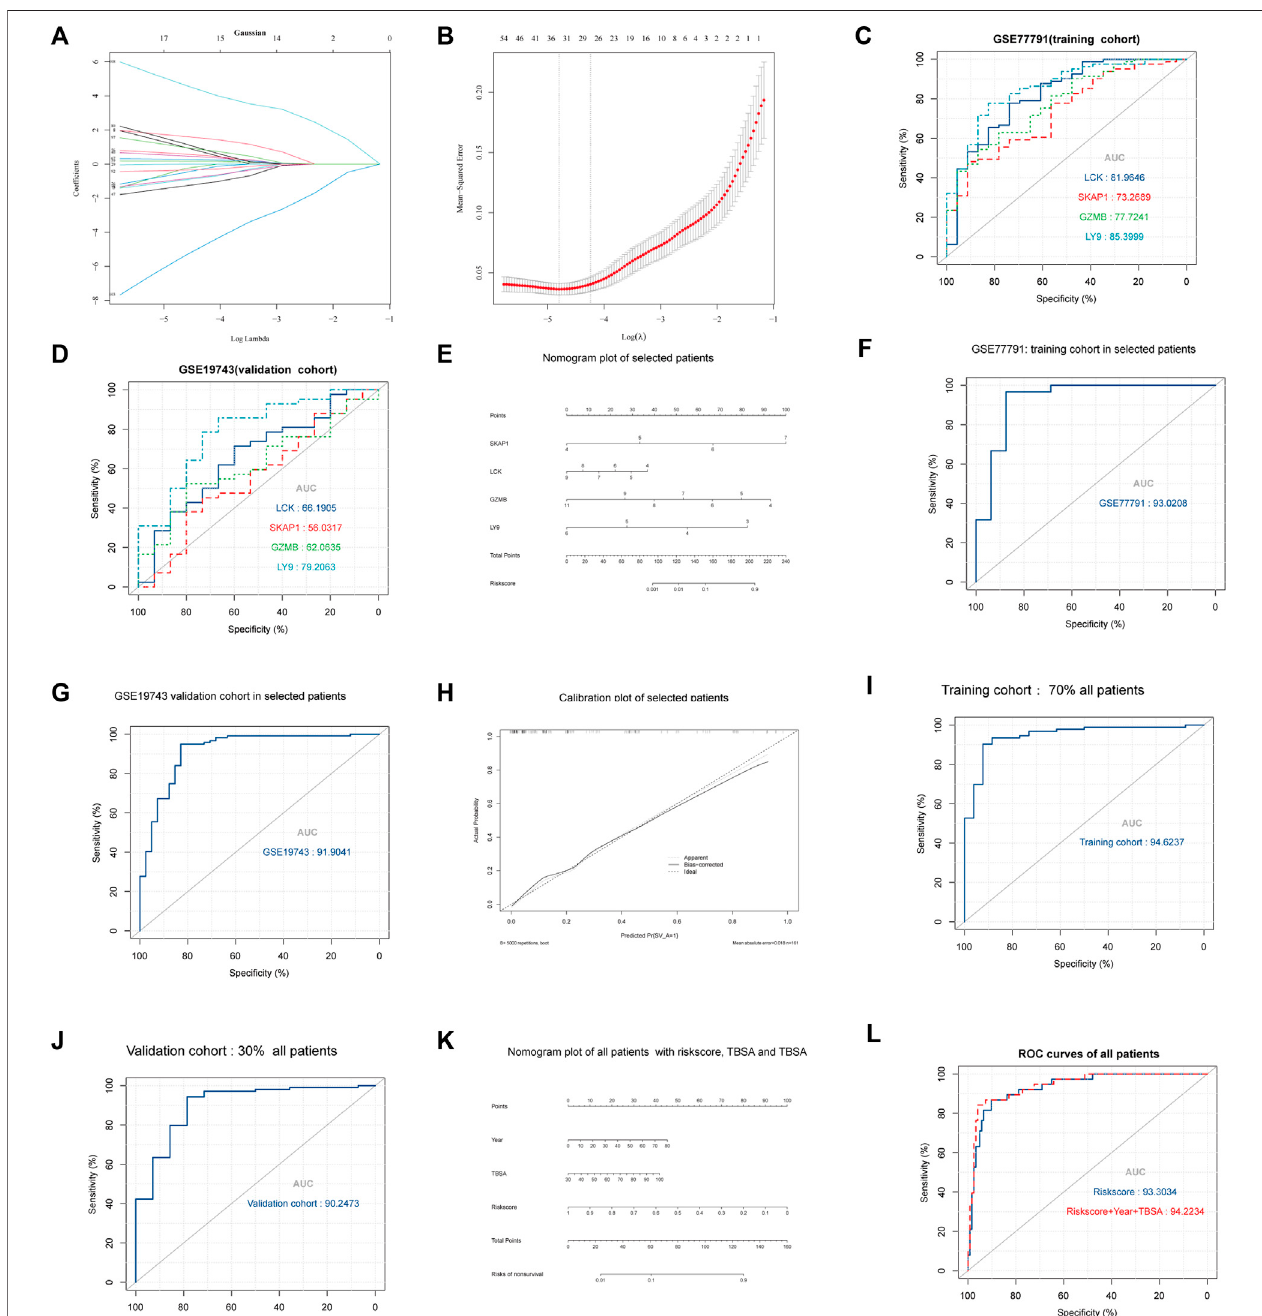
FIGURE 7 | Results of regression, multidimensional veri fi cation, and correlation between key genes and immune cells. (A,B) The ordinate is the correlation coef fi cient between gene expression and prognosis. λ was utilized to screened genes and the number aforementioned is the number of genes. (C) AUC of the four key genes in GSE77791. The larger the area under the curve, the stronger the prediction ability. (D) AUC of the four key genes in GSE19743. (E) Nomogram plot of logistic regression which can be utilized to calculate the risk score between severe burns and controls. (F) AUC of logistic regression with selected patients (18 < age < 55, TBSA > 30, 280 h < sample times < 706) in the training cohort (GSE77791). (G) AUC of logistic regression with selected patients (18 < age < 55, TBSA > 30%, 280 h < sample times < 706) in the validation cohort (GSE19743). (H) Calibration curve of logistic regression. The closer bias-corrected curve and ideal curve are, the better predictive regression model is. (I,J) Selected patients ( N = 104, 18 < age < 55, TBSA > 30, 280 h < sample times < 706) were divided into two cohorts in randomly to train and validate regression model, the training cohort had 70% patients, and the validation cohort had 30%. (K,L) All patients ( N = 161, 1 < age < 99, TBSA > 30%, 280 h < sample times < 706) in GSE77791 and GSE19743 were divided into two cohorts randomly to train and validate the regression model, the training cohort had 70% patients, and the validation cohort had 30%.